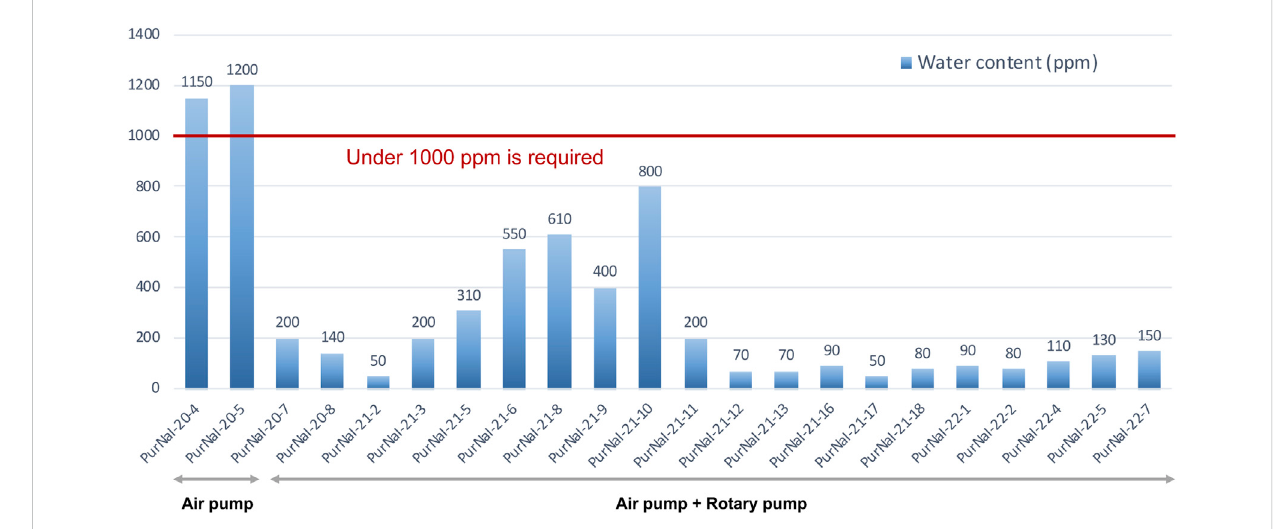
FIGURE 4 The water content measurement results by Karl-Fisher titrator for different batches of produced